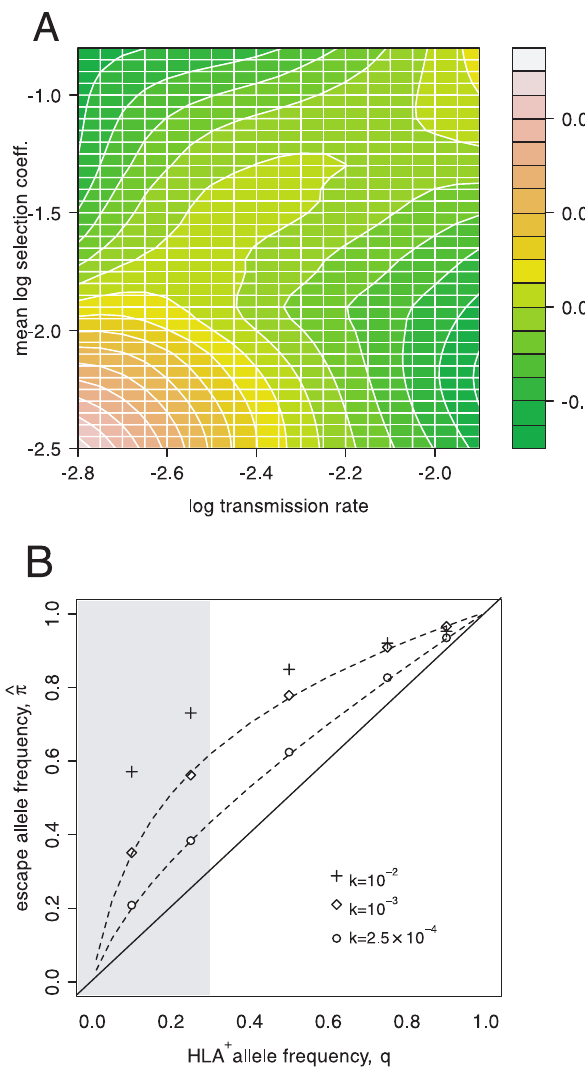
Figure 3. Factors Influencing Within-Host Polymorphisms and the Global Frequency of Escape Variants (A) A contour plot depicting the mean effect of selection and transmission rate on displacing the frequency of detectable poly- morphisms from the neutral expectation ( D f poly , refer to the color key), as estimated from simulations. (The expectation E[ f poly ] is jointly determined by the forward and back mutation rates, l and m , and population size, N .) The x -axis corresponds to the log-transformed transmission rate, log 10 k . The y -axis represents the mean log-transformed selection coefficient, E (log 10 s ) ¼ q log 10 ( s esc ) þ (1 (cid:4) q )log 10 ( s rev ) . (B) A 10-fold disparity in selection intensities s esc ¼ 0.02, s rev ¼ 0.002) causes ^ p to substantially exceed q with increasing transmission rate, k . Each set of points represents mean estimates of ^ p from simulations (with virus population size N ¼ 5,000 and l ¼ m ¼ 10 (cid:4) 4 ). Dashed lines indicate predicted values from the deterministic model, which performs poorly when k is too high (i.e., when transmissions occur rapidly, allele frequencies are almost always near zero or one where stochastic variation is greatest [31]). The typical range of q is indicated by the shaded plot region.